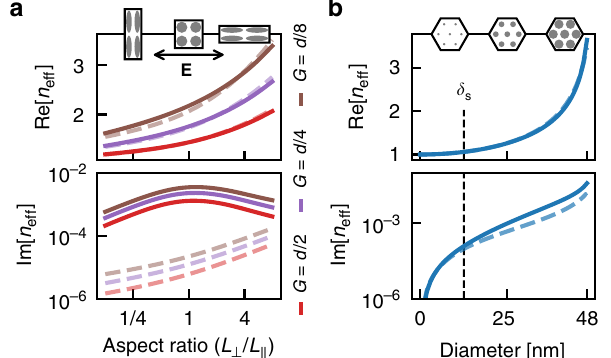
Fig. 5 The effective index of gold nanocylinders as functions of aspect ratio and particle size. Numerics (solid lines) and Maxwell Garnett mixing formula (dashes). a The aspect ratios of square arrays of cylinders were varied, while keeping the volume and surface-to-surface separation of each cylinder constant, as shown in the insets. The undistorted diameter of the cylinders was d = 30 nm and the incident wavelength was λ 0 = 200 μ m. b The cylinders were placed on a triangular lattice of length 50 nm, and their diameters were varied from 0 nm ≤ d ≤ 48 nm for an incident